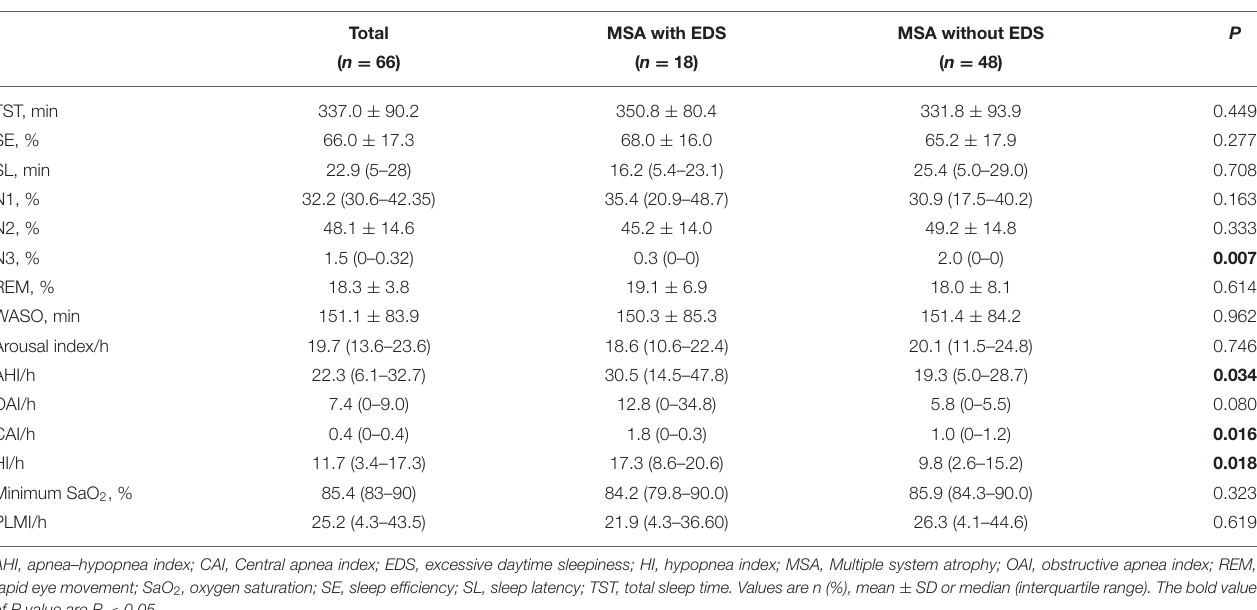
TABLE 3 | Comparisons of sleep parameters between MSA patients with and without EDS.